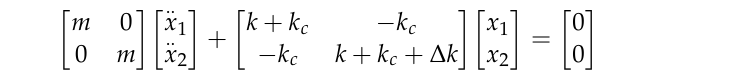
equations of the system can be given by